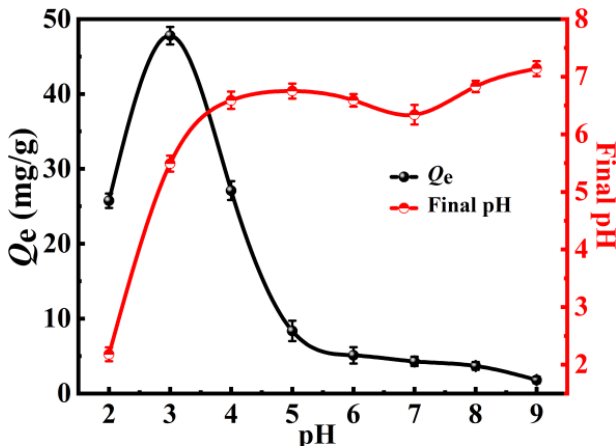
Figure 3. pH effect on defluoridation performance on LMF11 NFs and the final pH of the